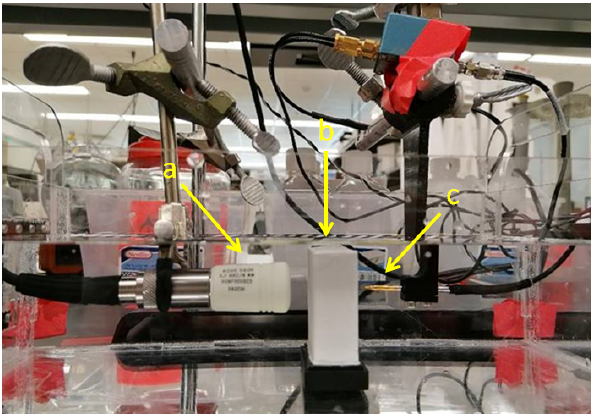
Figure 1. Setup used for the measurement of tissue-mimicking phantoms. ( a ) Piston-type US transducer (ROHE-5604), ( b ) phantom, ( c ) needle hydrophone (HNA-0400, ONDA, Sunnyvale, CA, USA) with amplifier (AH-1100, ONDA, Sunnyvale, CA, USA). The thickness of the phantom is 2 cm.